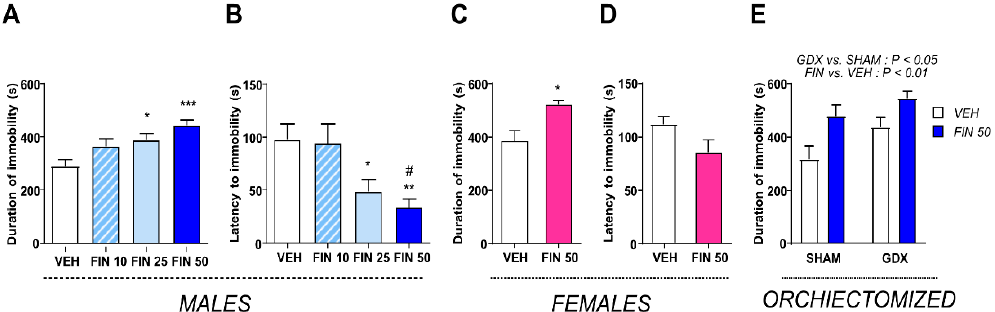
Figure 7. Finasteride (FIN) reduced stress coping behavior in the forced-swim test. In male rats, FIN increased the duration of immobility ( A ) and reduced the latency to immobility ( B ); n = 12/group. In female rats, FIN affected only the duration of immobility ( C ), but not the latency ( D ); n = 8–9/group. The depressogenic effect was not modified by gonadectomy ( E ); n = 9–11/group (GDX) ( E ). * p < 0.05, ** p 0.01, *** p < 0.001 in comparison with rats treated with vehicle (VEH); # p < 0.05 in comparison with FIN (10 mg/kg, IP). Doses of FIN are indicated in mg/kg (IP).